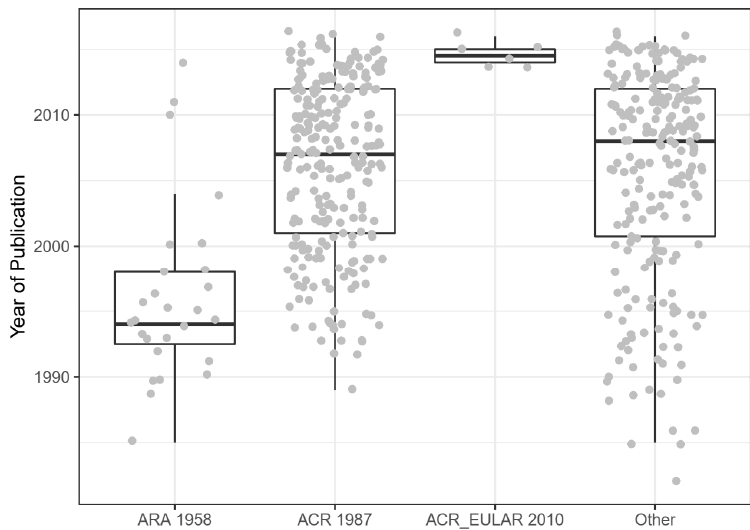
Figure 11. Publication date of human studies by diagnostic criteria. ACR 1987 criteria were also referred to as ARA 1987 criteria. Studies grouped under “other” reported the use of other criteria, or reported combinations of criteria, or did not report using specific criteria, or were in a language that the authors did not understand.